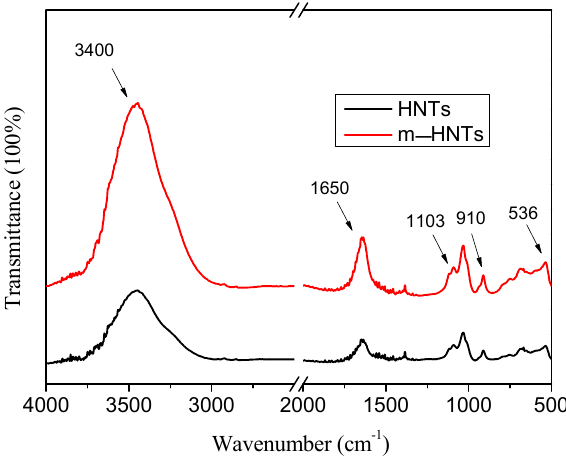
Figure 3. FTIR spectra of HNTs and m-HNTs.